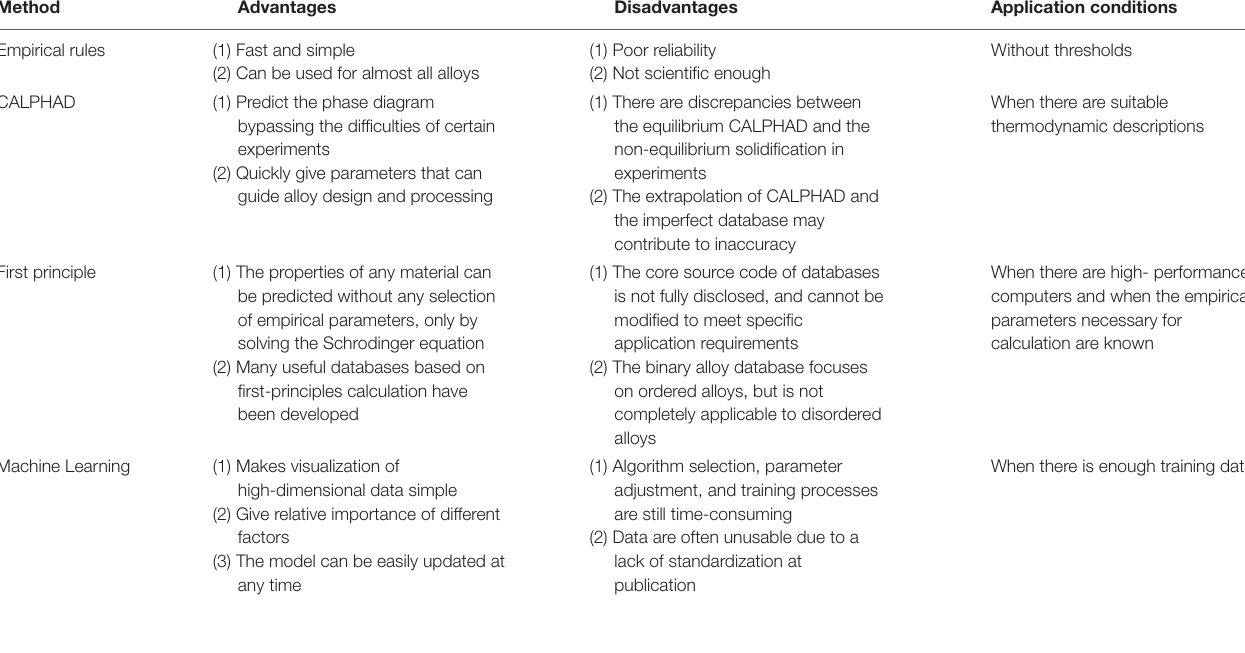
TABLE 2 | Comparison of the advantages, disadvantages, and application conditions of the four different high-throughput calculation techniques for HEA screening.